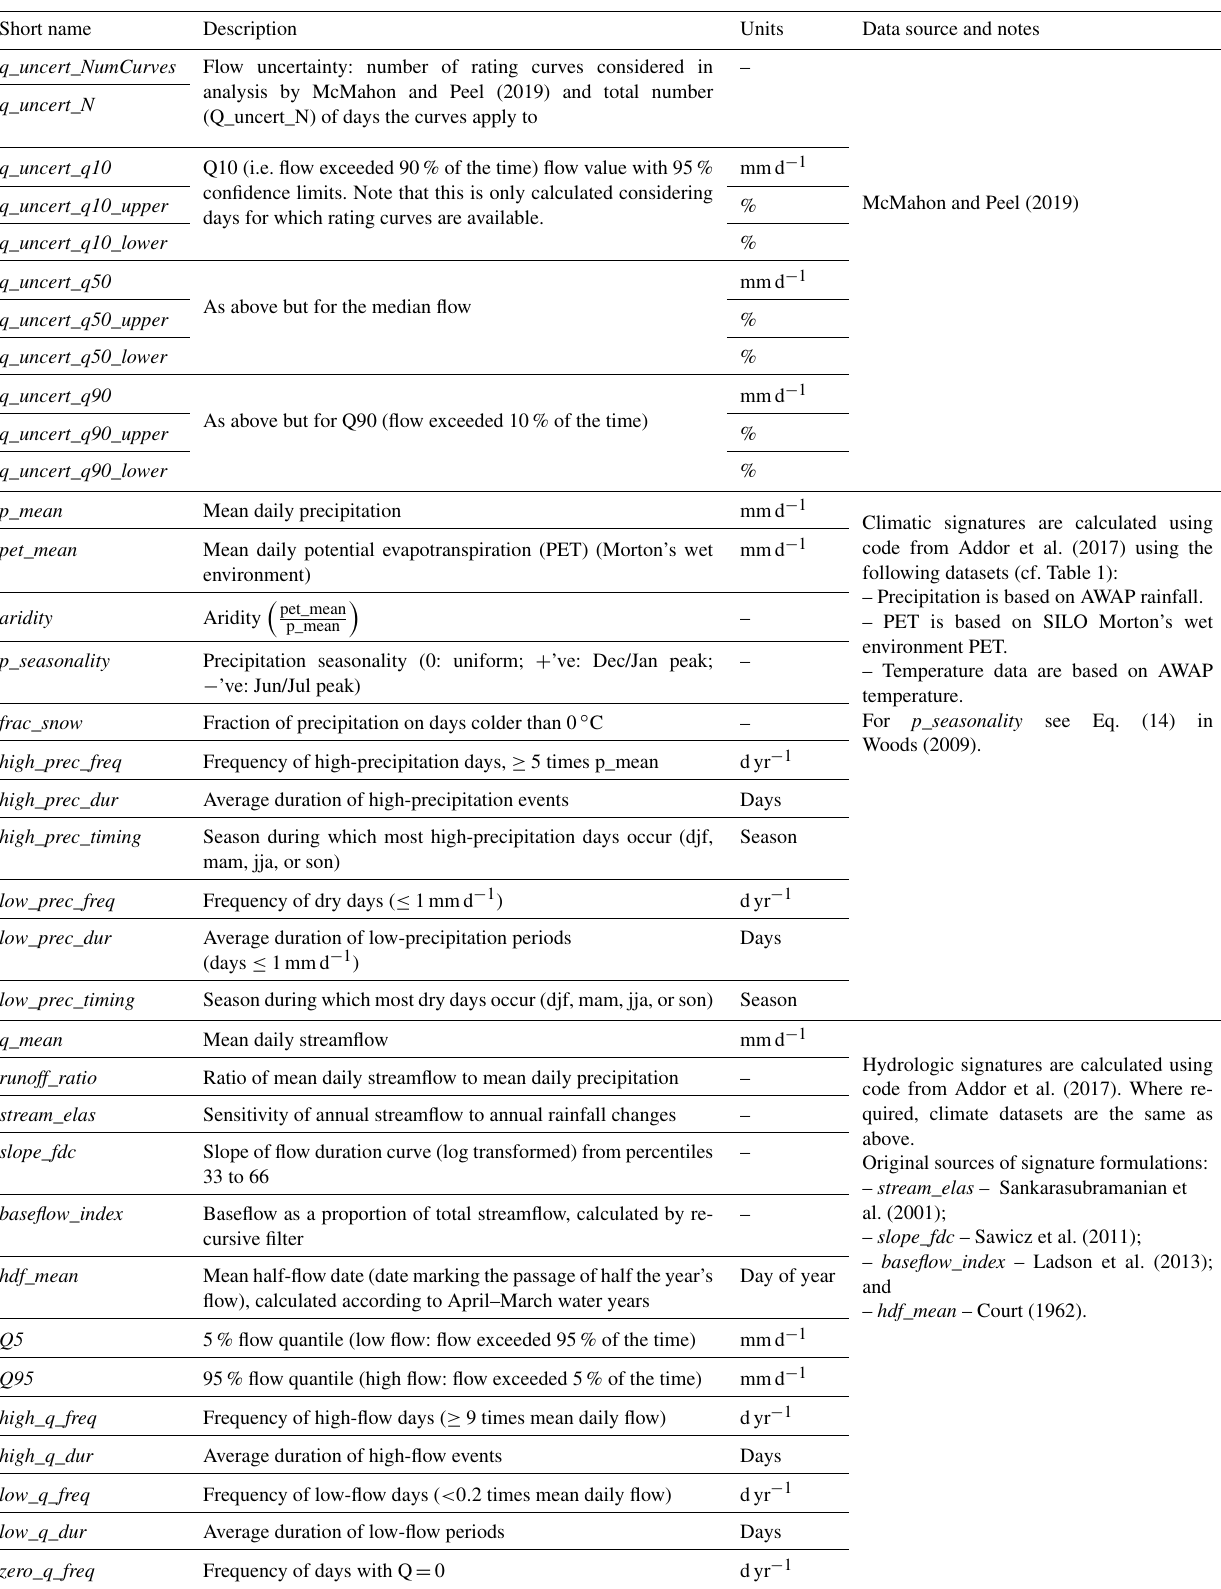
Table 3. Flow uncertainty information, climatic indices and streamflow signatures provided in the attribute table of CAMELS-AUS. Short